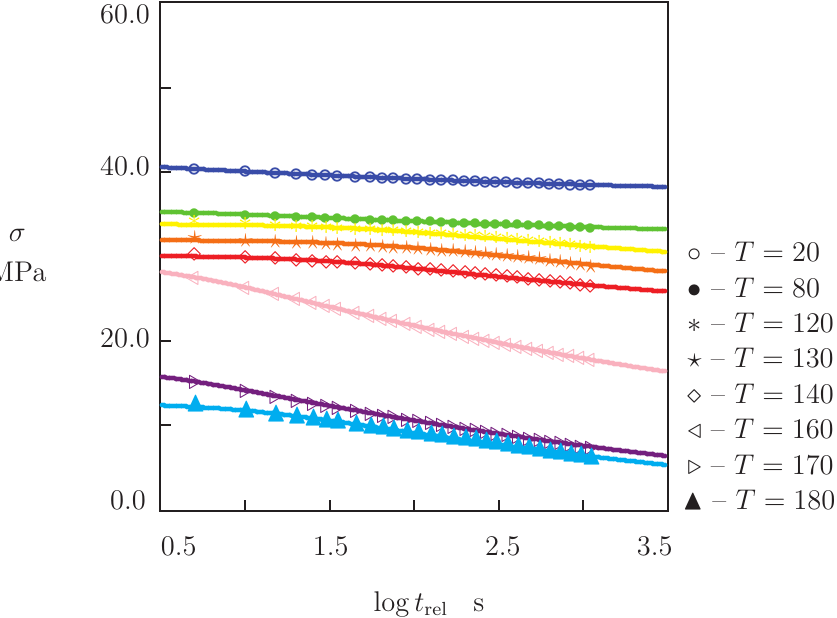
Figure 4. Stress σ versus relaxation time t rel . Symbols: experimental data in tensile relaxation tests with strain (cid:101) 0 = 0.01 at temperatures T ◦ C. Solid lines: results of